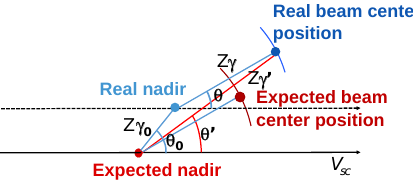
Figure B1. Definition of mispointing geometrical parameters γ 0 and θ 0 . We recall that Z is the satellite